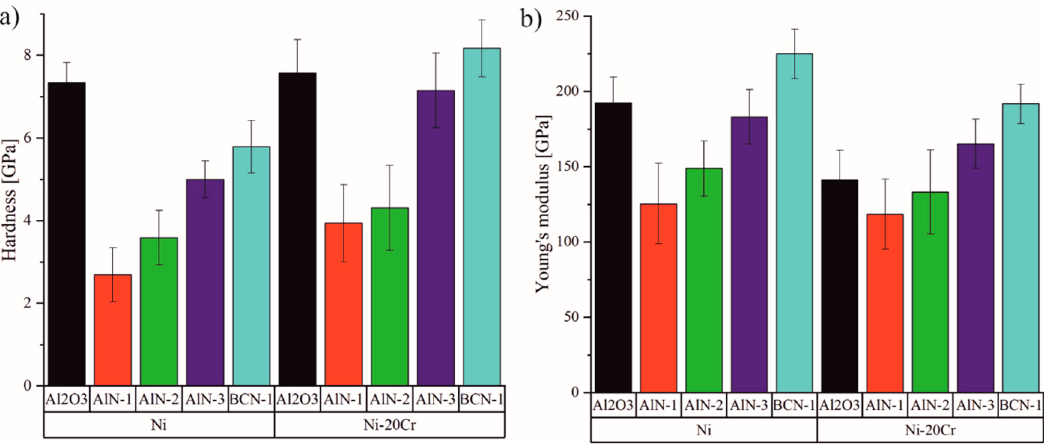
Figure 8. Influence of the substrate layer on the ( a ) hardness and ( b ) Young’s modulus of Ni and Ni-20Cr thin films.